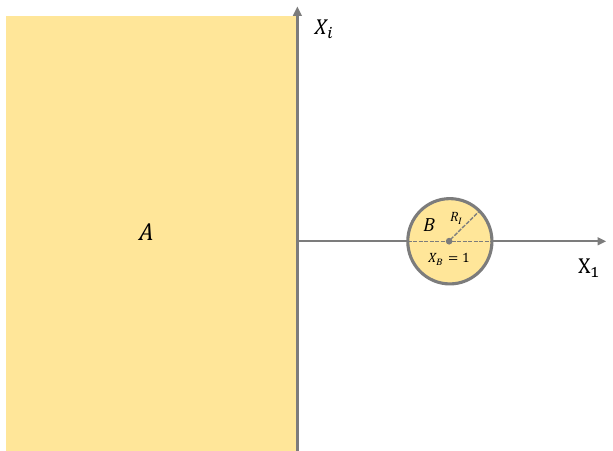
Figure 6 . Rindler frame: subregion A is the half space X 1 < 0 ; subregion B is a sphere whose center is located at X = (0 , 1 , 0 , . . . , 0) with small radius R B